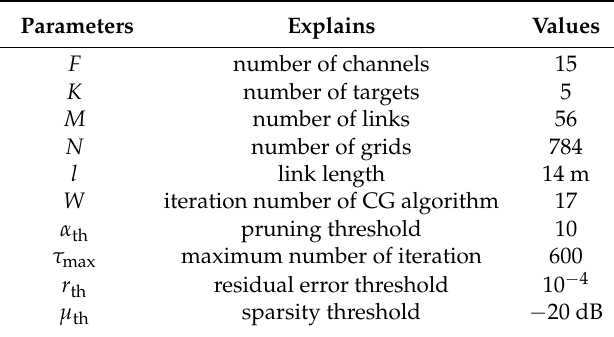
Table 1. Default values of simulation parameters.